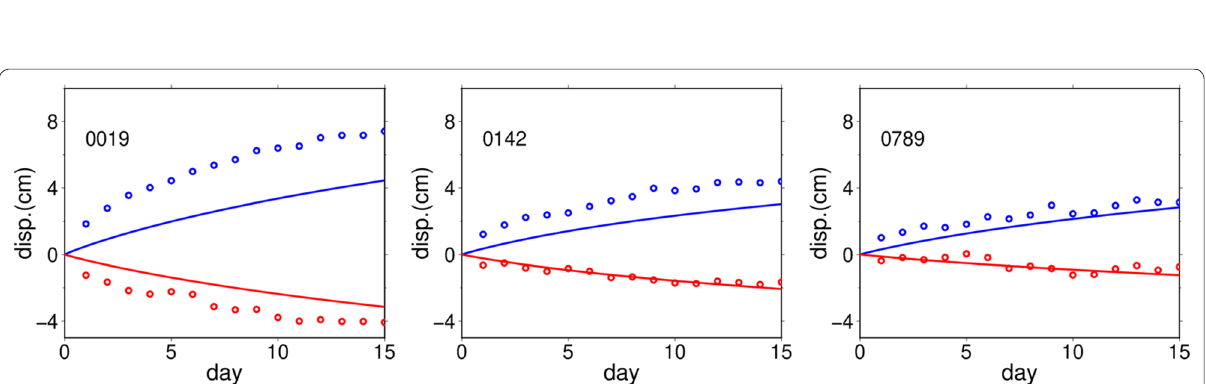
Fig. 15 Examples of the postseismic time series using the results of Kano et al. (2015). Red and blue circles indicate the GNSS time series in the X and Y directions. The red and blue lines are the corresponding theoretical time series calculated by using the optimum values obtained in Kano et al. (2015), which assimilated the slip velocities estimated by Miyazaki et al. (2004) as